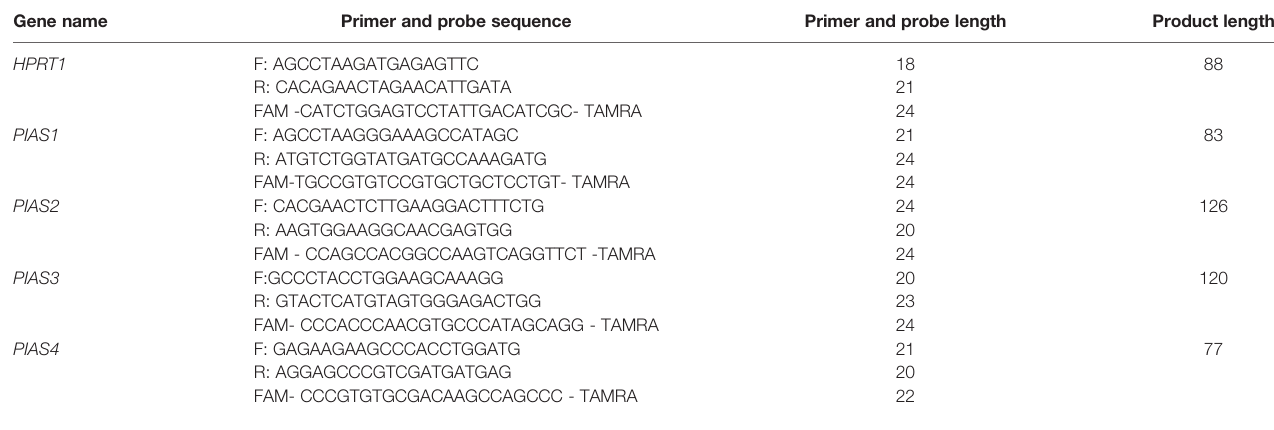
TABLE 1 | The information about primers and